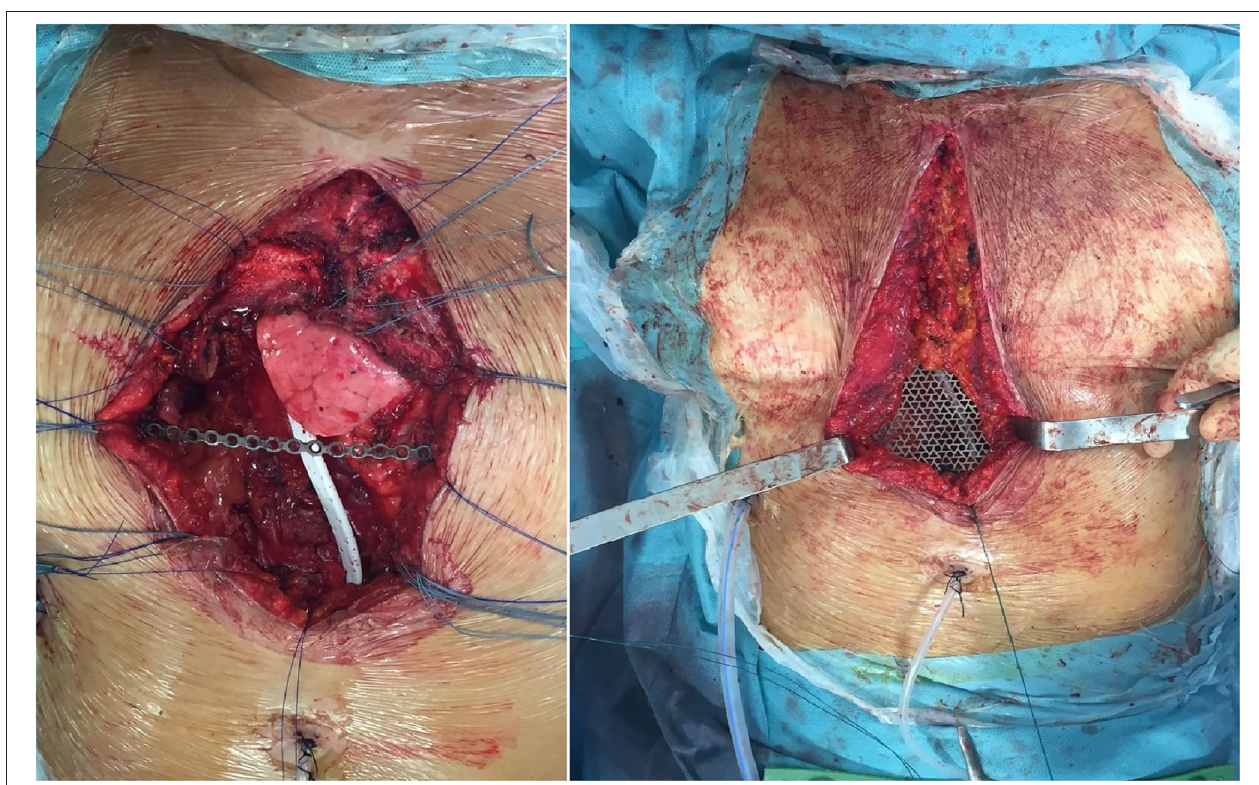
FIGURE 4 | Titanium mesh resting on a titanium support